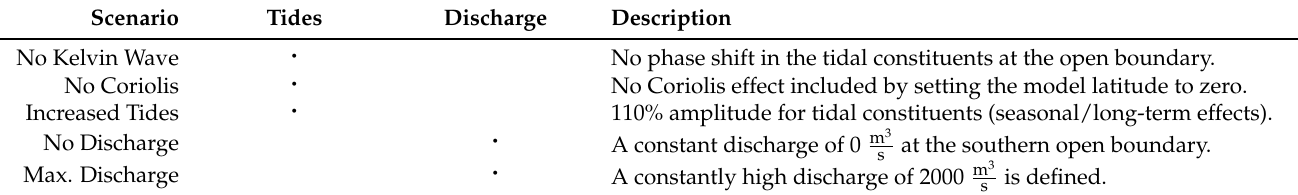
Table 1. Scenario Composition Synthesis: Listing of the scenarios selected for investigation on the left, based on the different aspects of the tides and river discharge that are potentially responsible for the formation of a two-channel system. The affiliation of the scenarios to either tides or discharge is indicated by the dots within the columns in the middle, followed by a description of the effects the scenario en- or disables, respectively. Scenario Tides Discharge Description · No Kelvin Wave No phase shift in the tidal constituents at the open boundary. · No Coriolis No Coriolis effect included by setting the model latitude to zero. · Increased Tides 110% amplitude for tidal constituents (seasonal/long-term effects). · No Discharge A constant discharge of 0 m 3 at the southern open boundary. s · Max. Discharge A constantly high discharge of 2000 m 3 is s